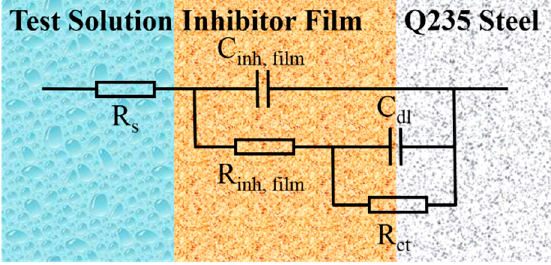
Figure 6. The equivalent circuit for electrochemical impedance spectroscopy (EIS) measurement.